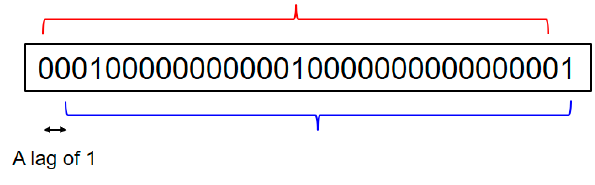
Figure 6. Illustrative example of binary record.